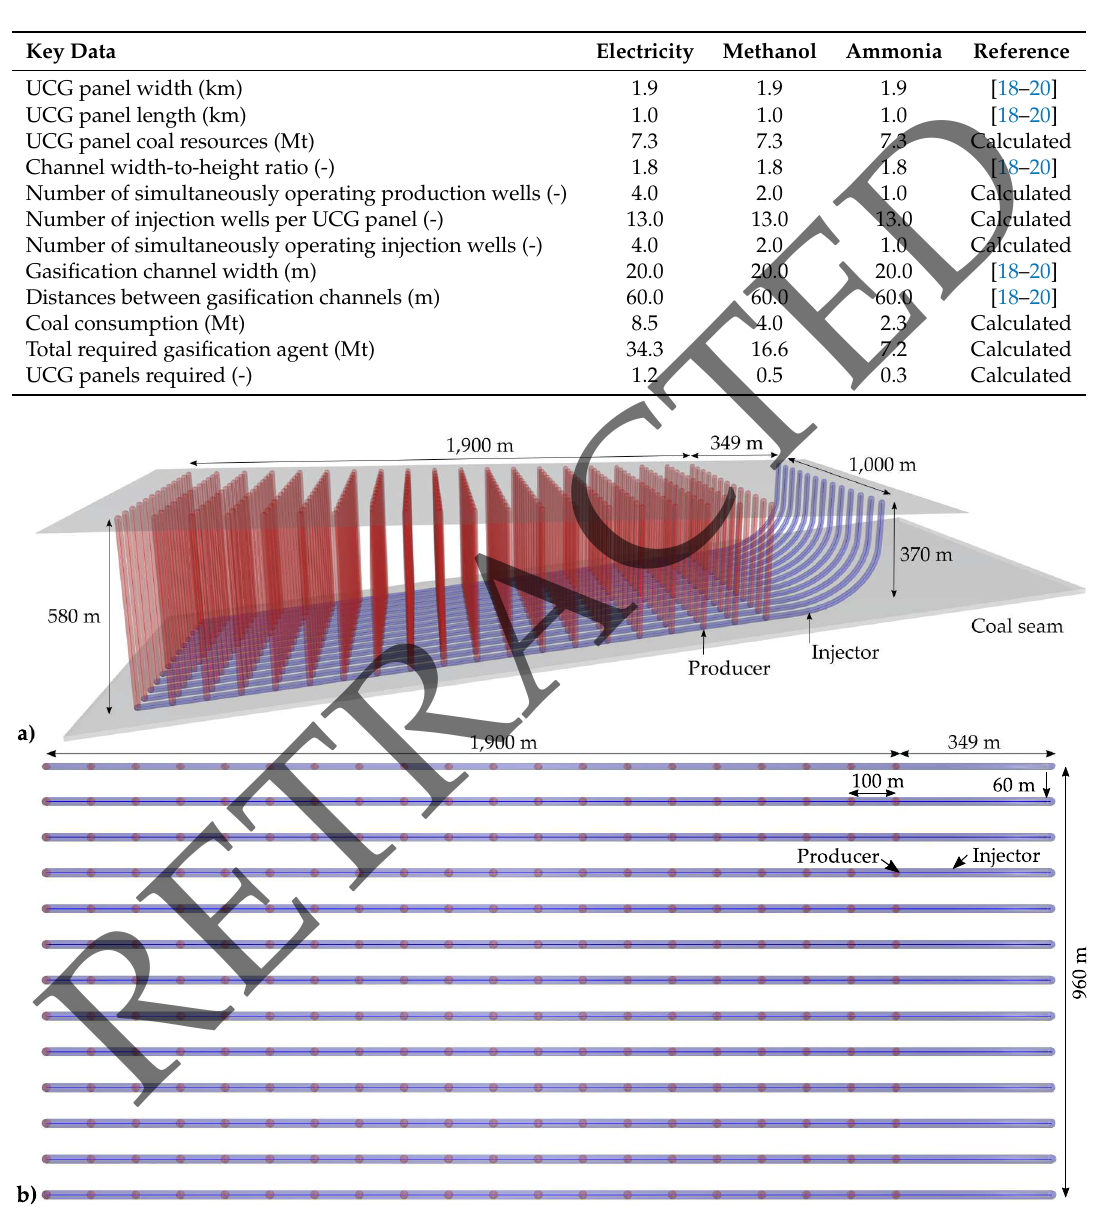
Table 2. UCG design adapted from Otto et al. [18] and adjusted to the investigated electricity, methanol and ammonia scenarios.